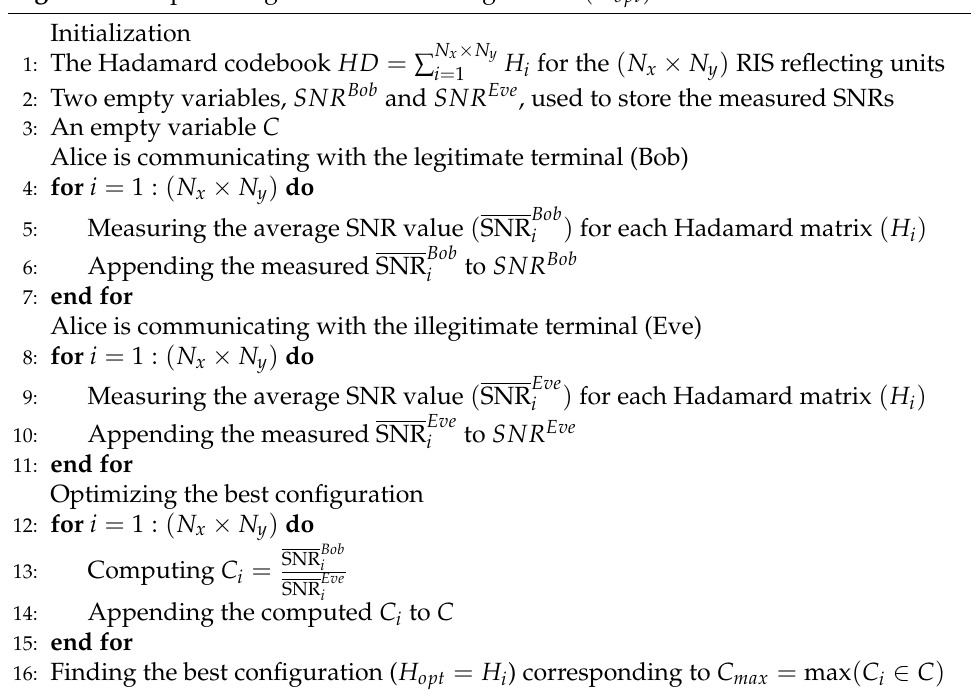
Algorithm 1 Optimizing the Best RIS Configuration ( H opt )